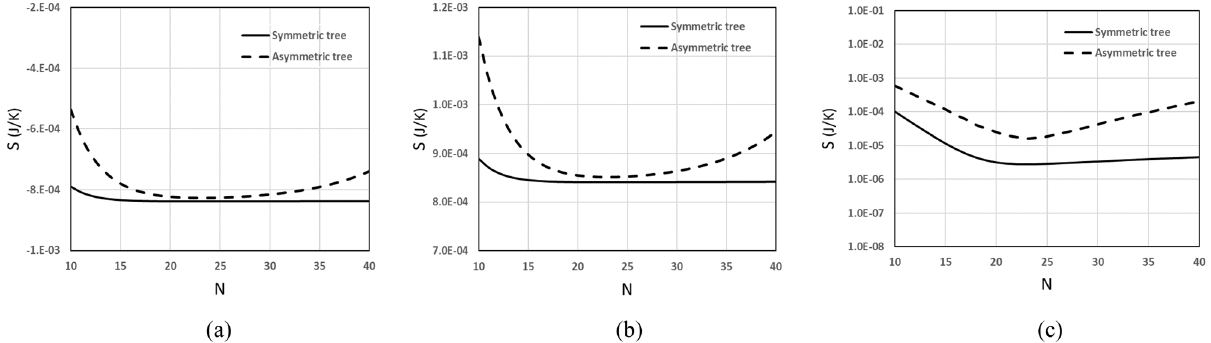
Figure 1. Entropy generation rate vs number of bifurcation levels: ( a ) inspiration (breathing in), ( b ) expiration (breathing out), and ( c ) respiratory cycle (one sequence of inspiration and